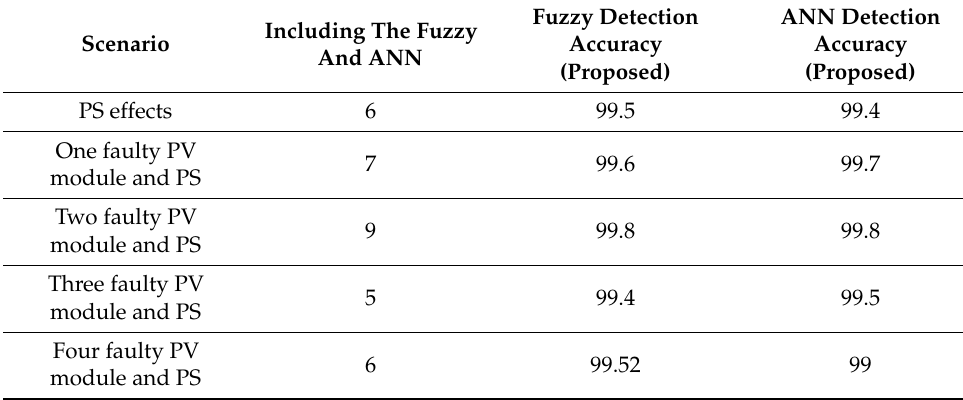
Table 3. Detection accuracy of two proposed